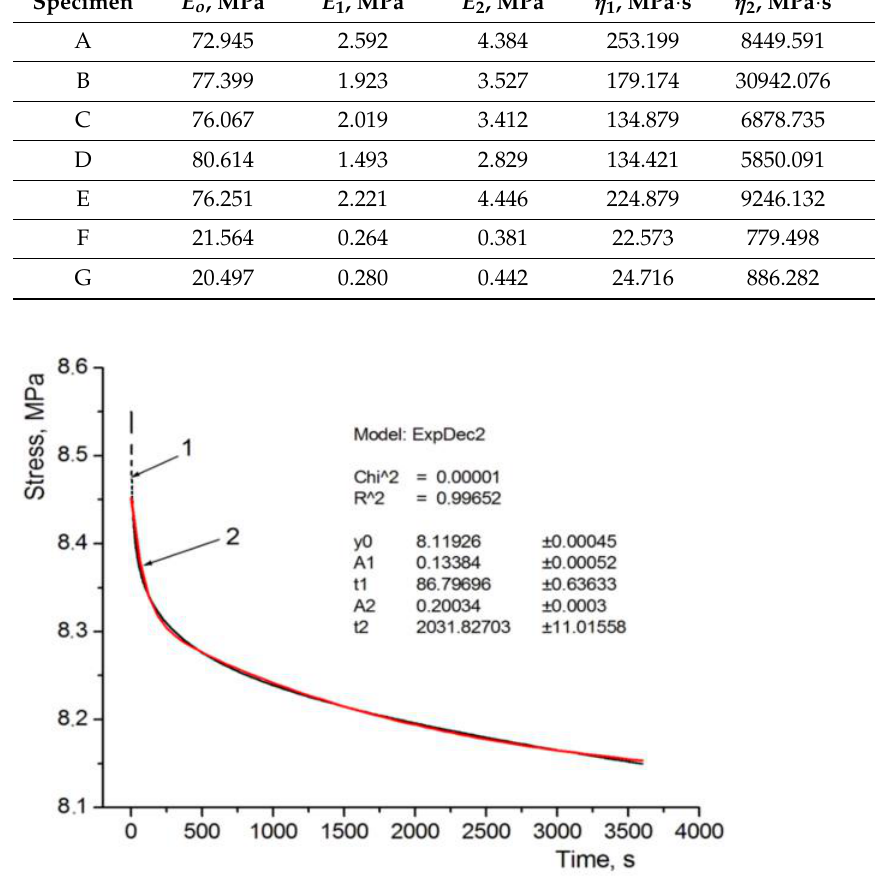
Figure 7. Approximation of the relaxation curve for sample D: 1—from the experiment; 2— relaxation